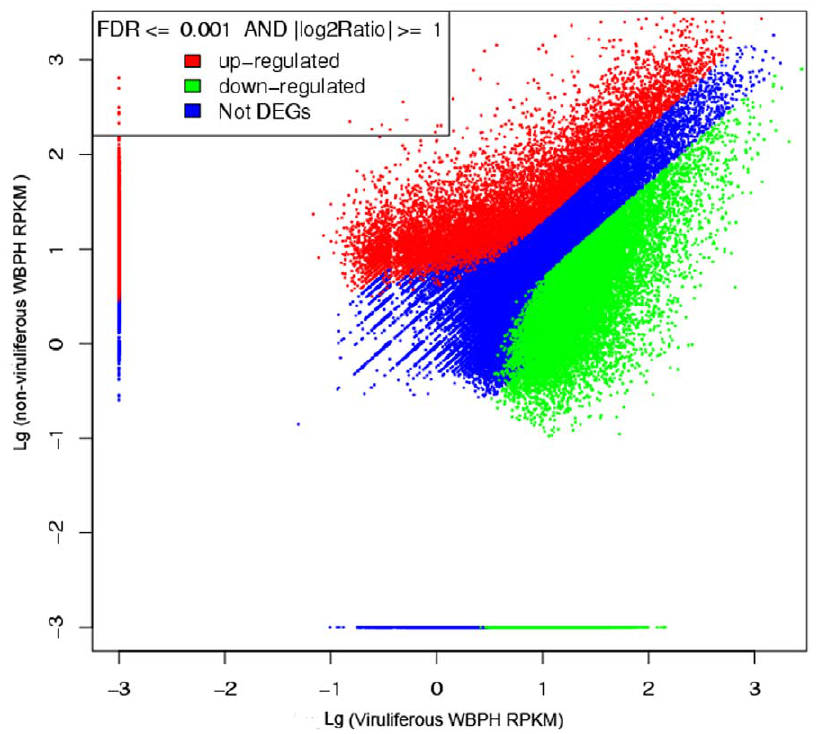
Figure 7. The bitmap of differentially expressed genes. The red and green points represent genes down-regulated and up-regulated genes in the viruliferous WBPH, respectively; the blue points represent genes that have no differences in regulation based on the criterion of FDR , 0.001 and an absolute value of the log 2 ratio . 1.